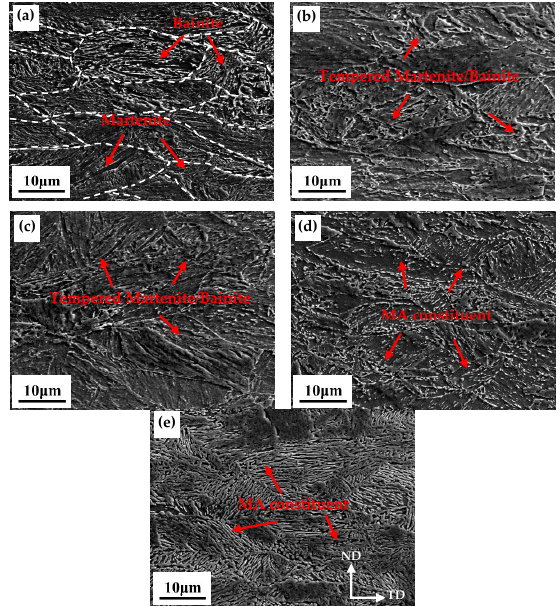
Figure 4. The scanning electron microscopy (SEM) micrographs of the tested steel under different aging conditions: ( a ) water cooling only, ( b ) aging at 500 °C, ( c ) aging at 600 °C, ( d ) aging at 650 °C, ( e ) aging at 700 °C.